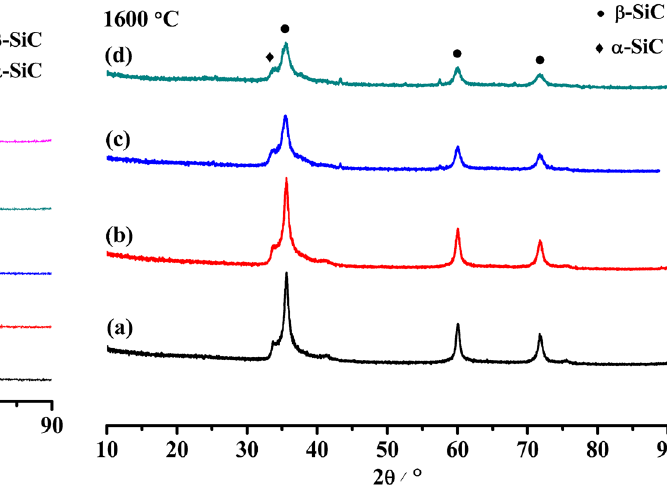
Figure 10: XRD patterns of 1,600°C ceramics derived from ( a ) AHPCS, ( b ) PACS - 1, ( c ) PACS - 3, and ( d ) PACS -